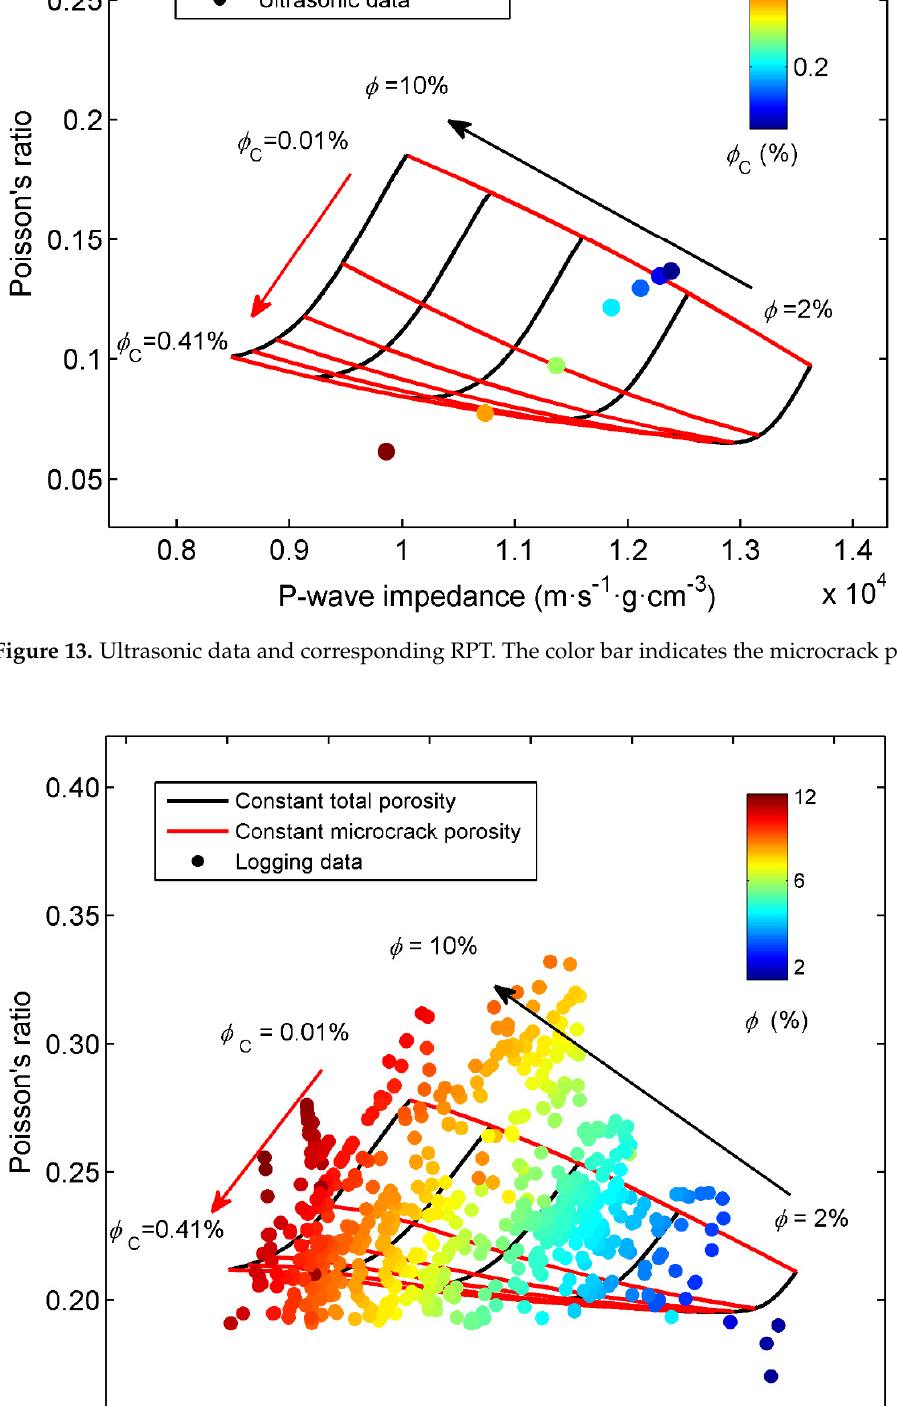
Figure 14. Log data and corresponding RPT. The color bar indicates the total